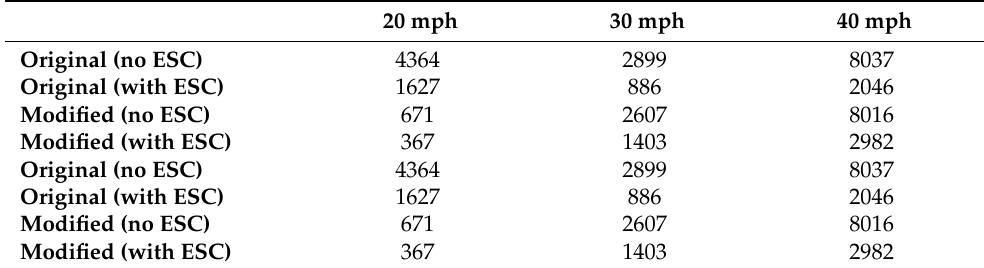
Figure 20. Simulator trial (sample data) for the modified Moose Test. Table 4. Cohort average simulator score summary (lower scores indicate better